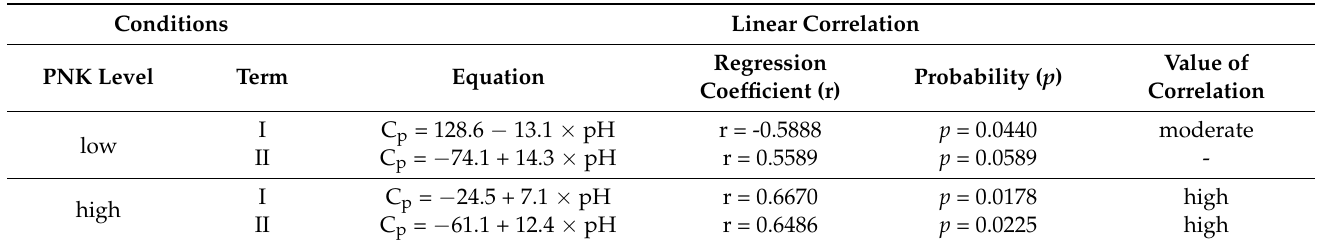
Table 10. The linear correlation between pH in water and content of cadmium ( µ g Cd · g − 1 d.w.) in Hydrocharis morsus-ranae (g) in the three tested growing seasons.